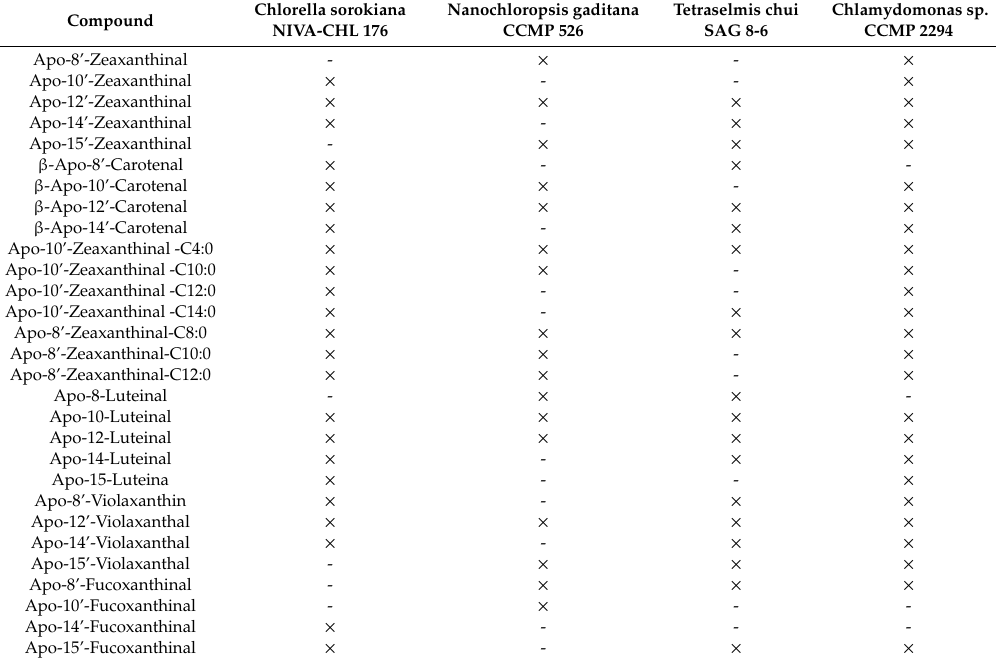
Table 2. Overall apocarotenoids occurrence in four microalgae